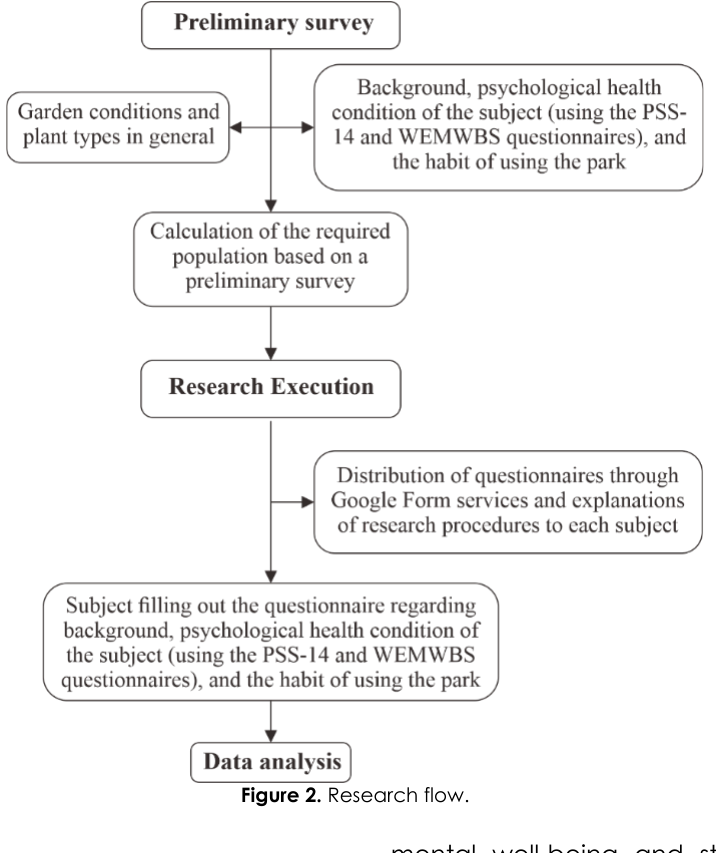
Figure 2. Research